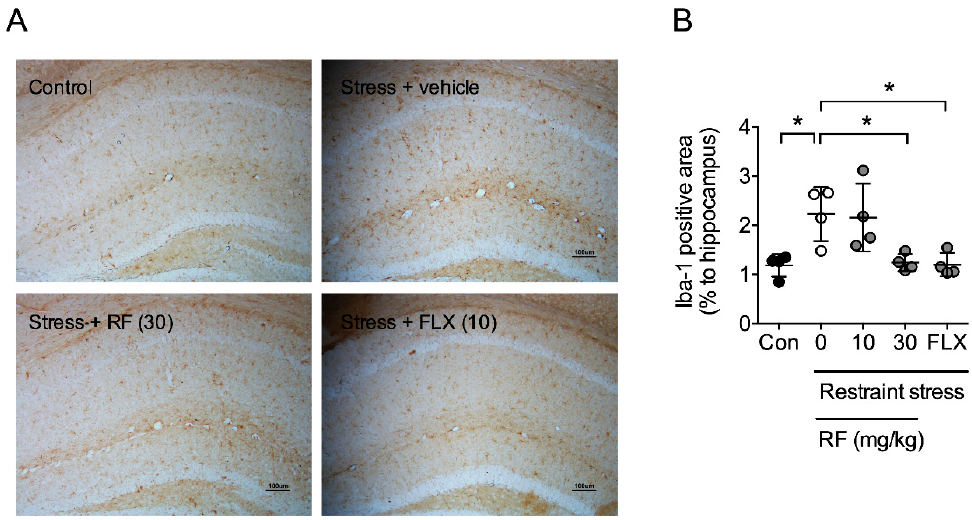
Figure 4. Effect of rubrofusarin on neuroinflammation: ( A ) Photomicroscopic image of Iba-1-immunopositive cells in the hippocampus. Bar = 100 µ m. ( B ) Quantitative analysis of Iba-1-immunopositive area in the hippocampus. Data represented as mean ± SD with raw data. * p < 0.05.